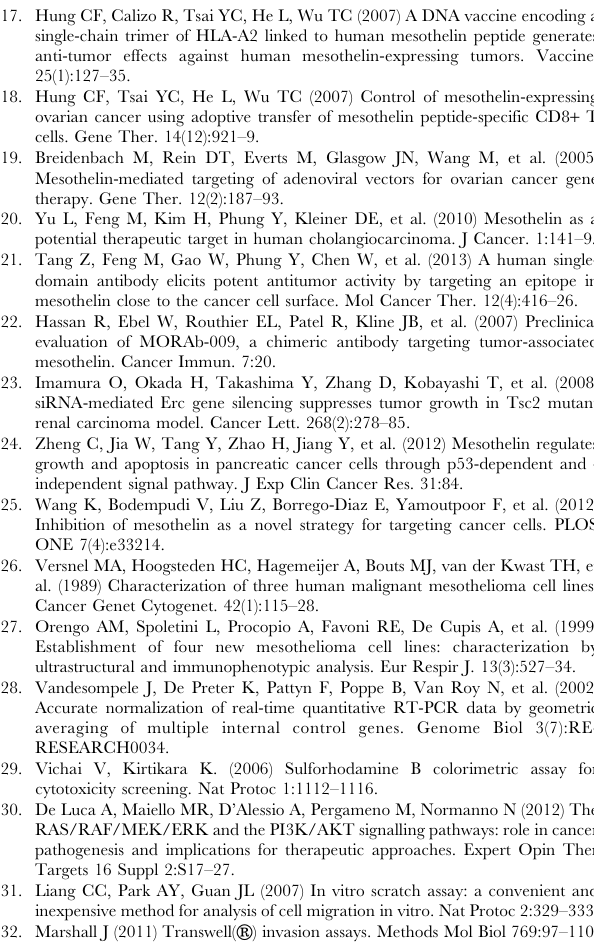
Table S2 Silencing-RNAs tested in the present